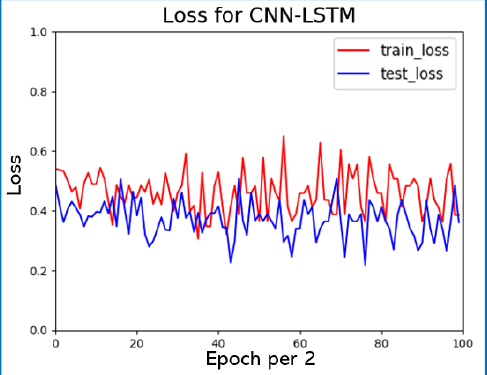
Figure 9. Train loss by CNN-LSTM algorithm.